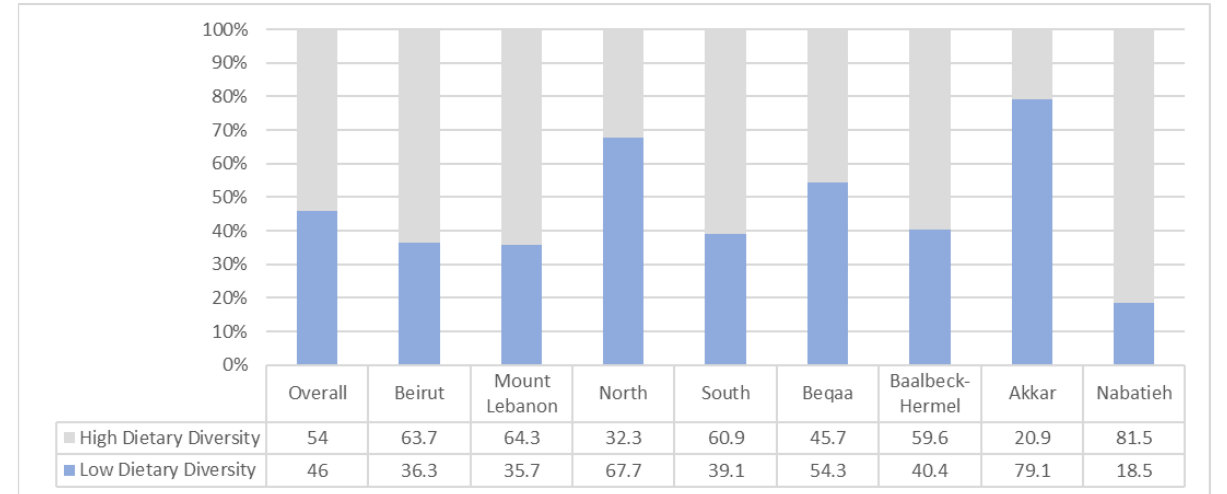
Figure 2. Households’ dietary diversity, overall and by governorate.